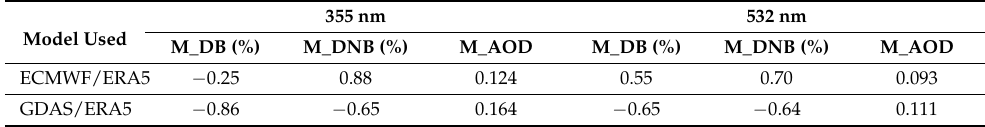
Table 7. Same as Table 6, but for two different forecast models compared with the corresponding reanalysis